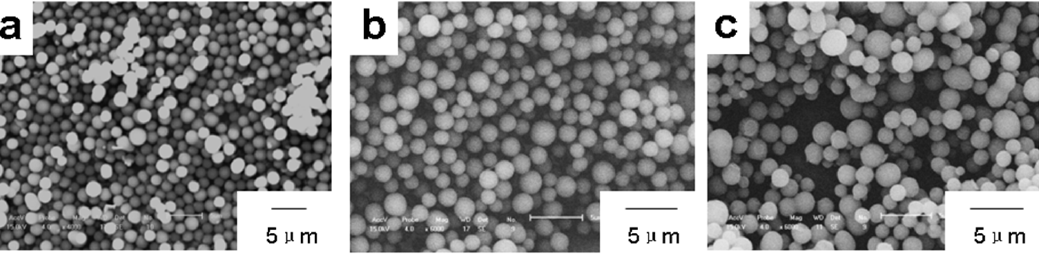
Figure 5. SEM images of polymer microspheres prepared when the molar ratio of HCCP to bi- sphenol was 1:6: ( a ) 6FPZF micro-nanospheres; ( b ) 3FPZF micro-nanospheres; ( c ) TPZF mi- cro-nanospheres.